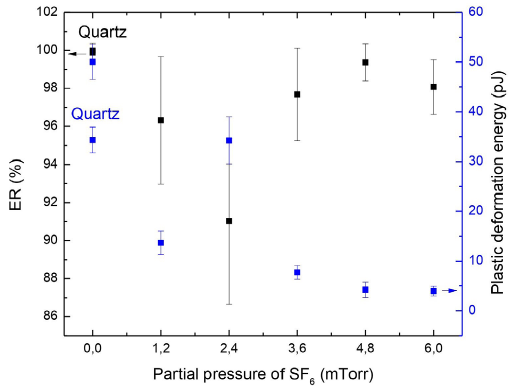
Figure 17. Elastic recovery and plastic deformation energy as a function of